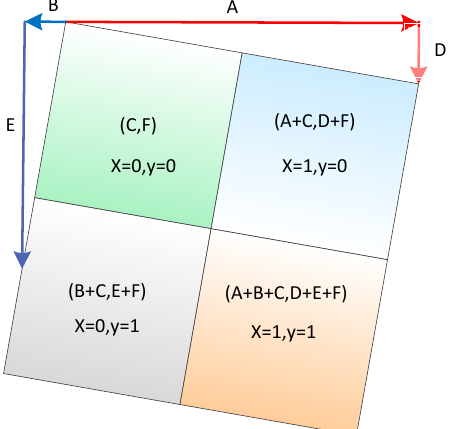
Figure1. The image georeferenced based on the world